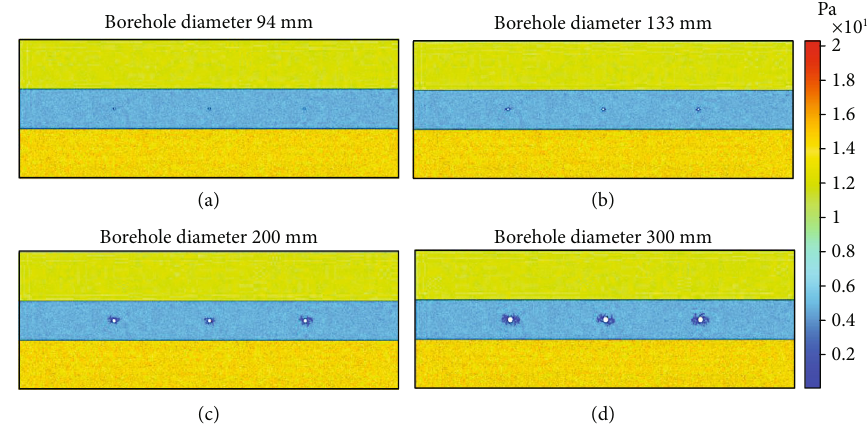
Figure 4: Distribution of elastic modulus of soft coal seam with di ff erent borehole diameters.